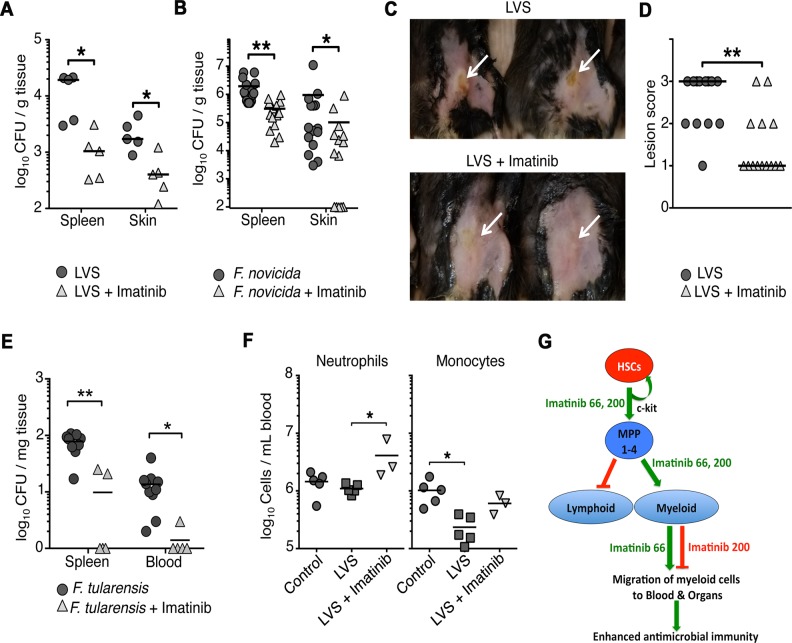
Imatinib decreases bacterial load of pathogenic Francisella spp. in vivo.
(A-B) C57Bl/6 mice were treated with imatinib at 66 mg/kg/d or water for 7d prior to infection and for the duration of the experiment, and then injected subcutaneously with either ~6x106 Fn (A) or ~2x105 LVS (B). After 48h for Fn or 5d for LVS, skin and spleens were collected and CFU/gram of tissue was determined. The limit of detection of the assay was 100 CFUs. (C) Images of lesions on control or imatinib-treated mice infected with LVS. Hair was removed from injection site. The lesions are indicated by white arrows. (D) Quantitation of lesions from control or imatinib-treated mice. Lesions were scored on a scale of one to three, with a score of one denoting no visible lesion, two a visible lesion but without a break in the skin, and three an open wound. 15 animals were scored per condition. (E) Four days following infection with strain Ft Schu S4, CFU/gram of tissue was determined. The limit of detection of the assay was 100 CFU/gm for Ft. The line in each data set represents the median. A Mann-Whitney nonparametric test was used to determine significance. Combined data from three independent experiments are shown. (F) Effects of imatinib at 66mg/kg/d on neutrophils and monocytes upon infection with LVS. Data from a representative experiment are shown. (G) Summary of effects of Imatinib on myelopoiesis and migration of mature myeloid cells to the blood and organs. Imatinib at doses of 66 or 200 mg/kg/day induces activation, expansion, and maturation of hematopoietic stem cells (HSCs) and multipotent hematopoietic progenitors 1–4 (MPP1-4) in the bone marrow. Imatinib at these doses also stimulates a lineage determination step that induces MPPs to differentiatiate into myeloid precursors and then mature cells (green arrow), but not into cells of the lymphoid lineage (red arrow). Data with low doses of neutralizing antibodies against the c-Kit tyrosine kinase support the hypothesis that effects on HSCs and MPPs are mediated by partial inhibition of c-Kit, whereas effects of the drug on lineage determination appears to be independent of c-Kit. Ultimately, imatinib increases the numbers of mature myeloid cells in the bone marrow, an effect seen with drug alone; the accumulation of mature cells is not evident with the drug in context of infection, which itself appears to mobilize migration of mature cells from the bone marrow to the periphery. Notably, increased numbers of mature cells are only evident in the blood and tissues at lower doses (66mg/kg/d), suggesting that at low doses, Imatinib induces migration of mature cells out of the bone marrow; alternatively, the drug may inhibit migration at higher doses (200mg/kg/d). Importantly, Imatinib mimics the “emergency response” to infection, which likewise induces HSC activation, MPP expansion, myelopoiesis, and migration of mature myeloid cells from the bone marrow to the periphery (green arrows).